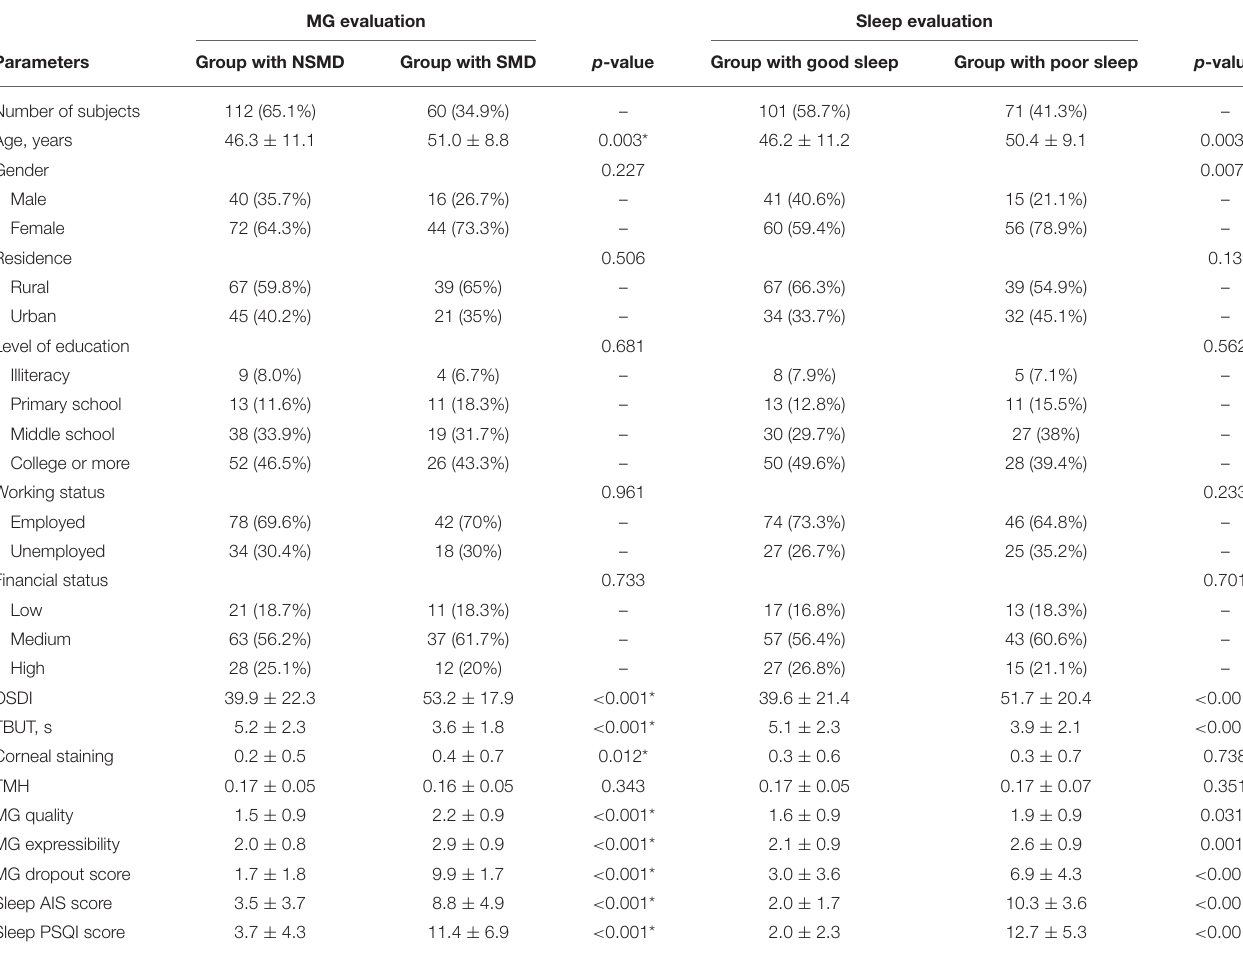
TABLE 1 | Demographic characteristics of study subjects: sleep characteristics and dry eye